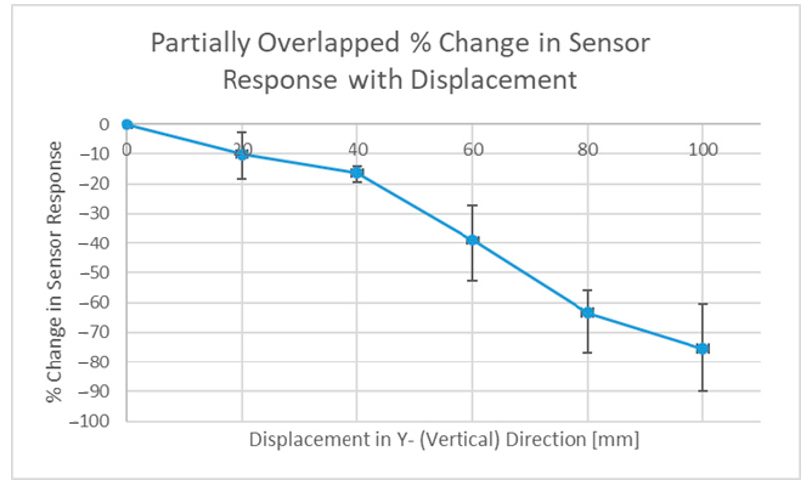
Figure 18. Response magnitude results from partially overlapped distribution.